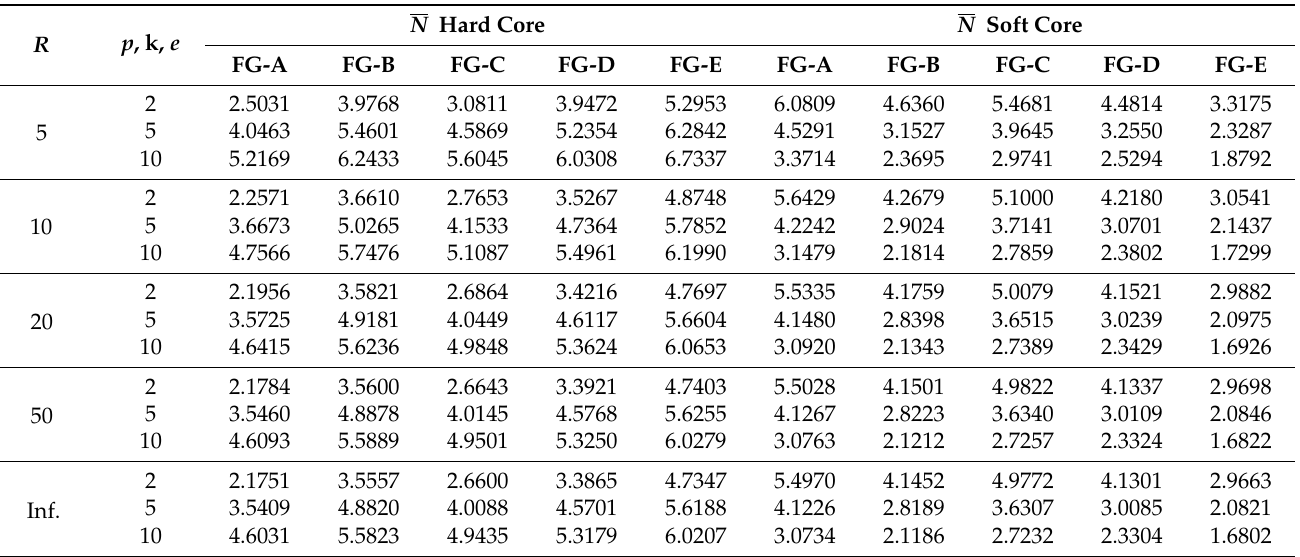
Table 4. Dimensionless critical buckling load N of FG shells for various radii of curvature (cid:0)